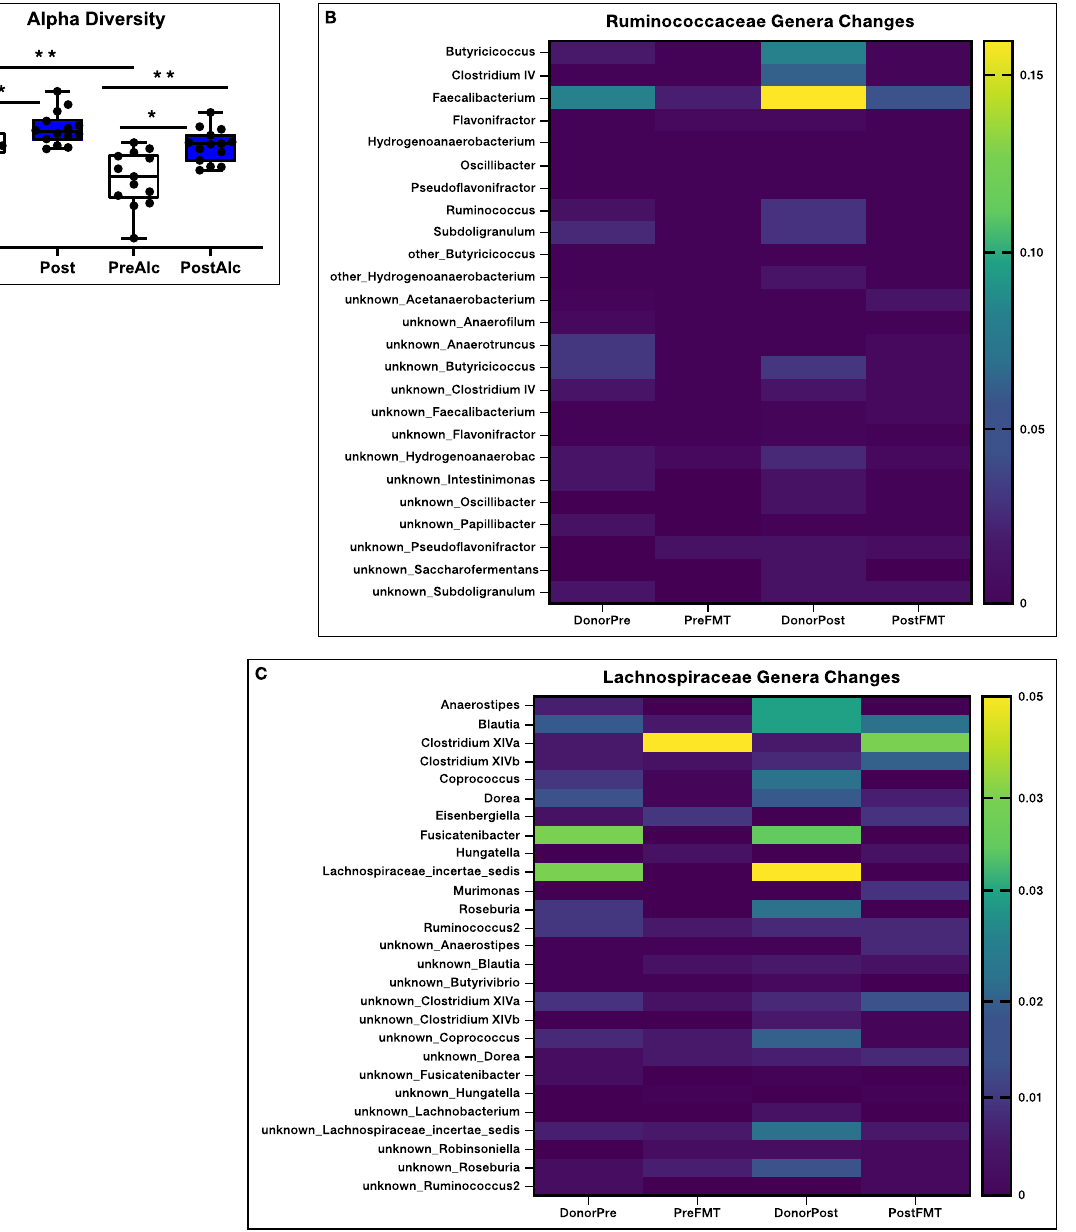
Fig. 4 | Stool microbial diversity and transmission of Lachnospiraceae and Ruminococcaceae constituents. A Shannon diversity index of stool microbiota showed lower alpha-diversity in pre-FMT versus post-FMT even before alcohol exposure.Alcoholexposurefurtherworsenedthisinbothgroups.PrePre-FMTbut notexposedtoalcohol,PostPost-FMTbutnotexposed toalcohol,PreAlcPre-FMT after alcohol exposure, PostAlc Post-FMT after alcohol exposure, ** p <0.01, * p <0.05, Mann – Whitney for unpaired and Wilcoxon signed rank test for paired analyses (before/after alcohol) one-sided. There were 14 mice per group. Data presentedasmedian,95%CI(boxplot)withindividualvaluesandtheentirerangein the error bars. B Ruminococcaceae and C Lachnospiraceae genera heatmap of